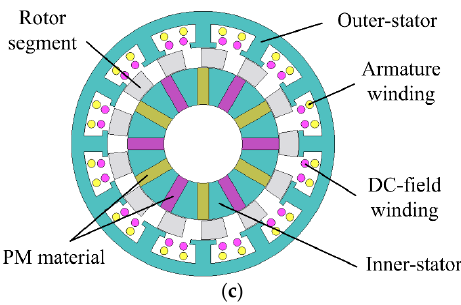
Figure 1. Proposed machines: ( a ) The partitioned-stator switched-flux permanent-magnet (PS-SFPM); ( b ) flux adjuster (FA)-PS-SFPM; ( c ) partitioned-stator switched-flux dual-excitation (PS-SFDE). PM–permanent magnet.